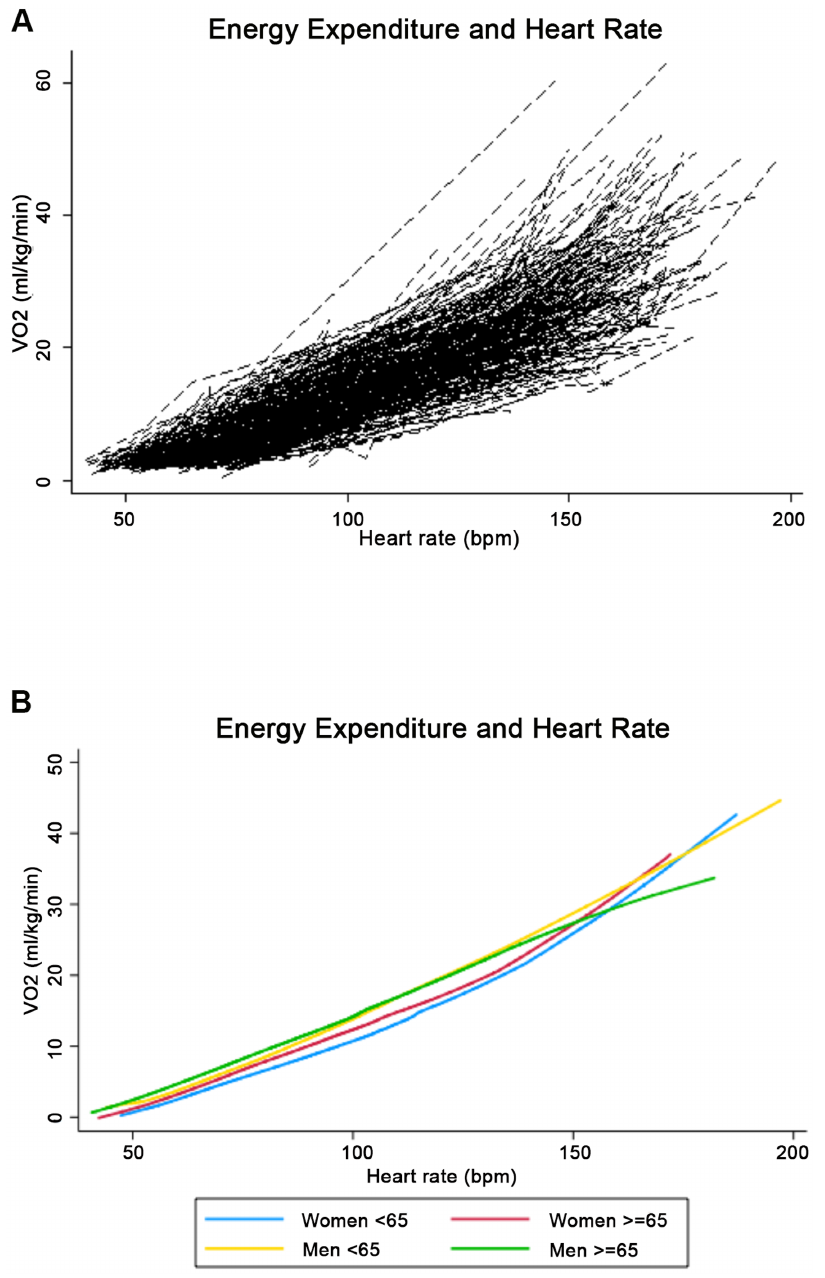
Figure 1. a shows a spaghetti plot (N=290) of the relationship between heart rate (bpm) and energy expenditure (ml/kg/min). b shows an age and sex stratified LOWESS of the relationship between heart rate (bpm) and energy expenditure (ml/kg/min).